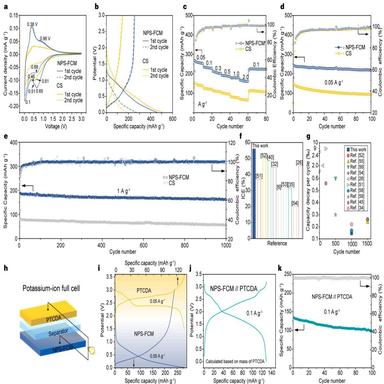
Potassium storage performance of NPS-FCM material. a) Cyclic voltammetry curves of NPS-FCM and CS materials in the voltage range of 0.01–3.0 V (vs K/K+) at the scan rate of 0.1 mV s − 1 . b) Charge-discharge profiles of initial two cycles at 0.05 A g− 1 . c) rate properties and cycle performance at d) 0.05 A g− 1 and e) 1 A g− 1 . Performance comparison of NPS-FCM and recently reported carbon anodes of PIBs in literature: f) ICE comparison and g) cycle stability comparison. h) Schematic illustration of the